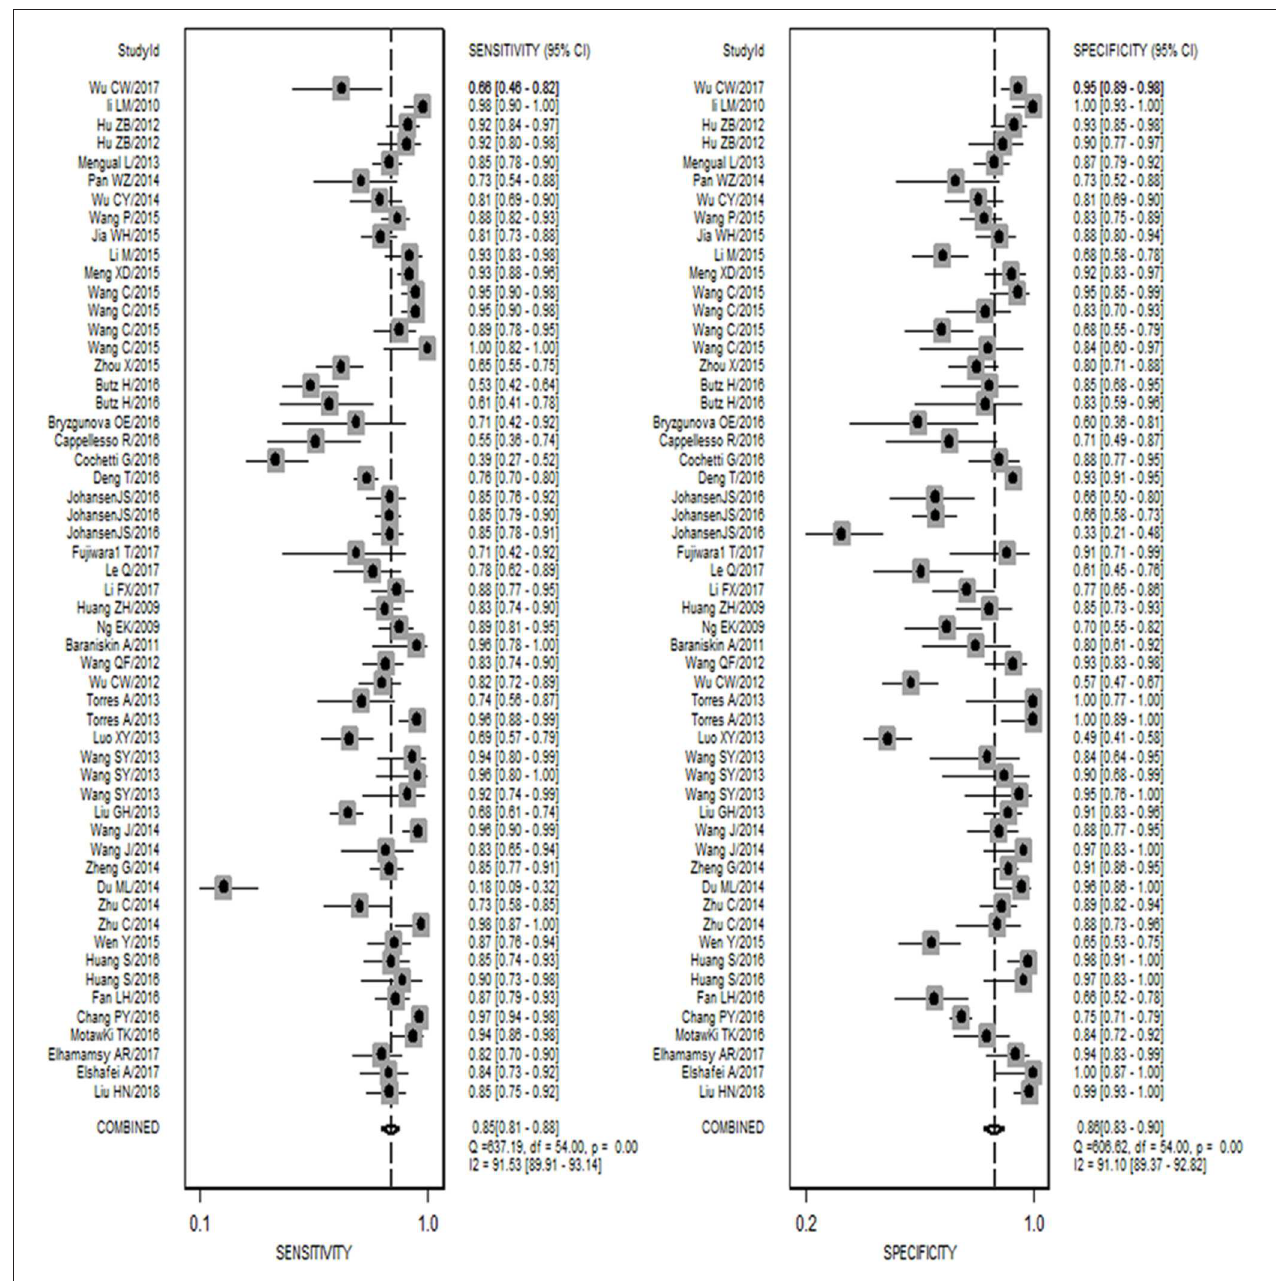
FIGURE 2 | Forest plots of sensitivity and specificity for the cancer diagnosis of miR-92a family. Both the sensitivity and specificity of each study were showed by each square with its 95% confidence interval showed by the error bars.